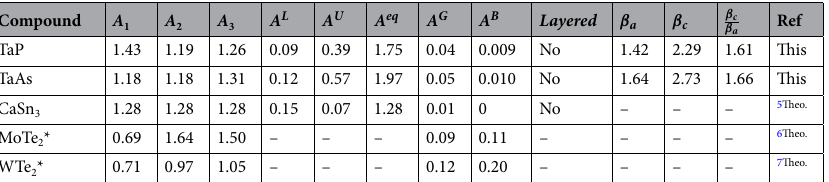
Table 4. Shear anisotropic factors ( A 1 , A 2 and A 3 ), universal log-Euclidean index A L , the universal anisotropy index A U , equivalent Zener anisotropy measure A eq , anisotropy in shear A G (or A C ) and anisotropy in compressibility A B , linear compressibilities ( β a and β c ) (TPa −1 ) and their ratio (β c /β a ) for Ta X ( X = P, As) at P = 0 GPa and T = 0 K. For comparison, the anisotropy indices of some other WSMs are also given. *Orthorhombic.